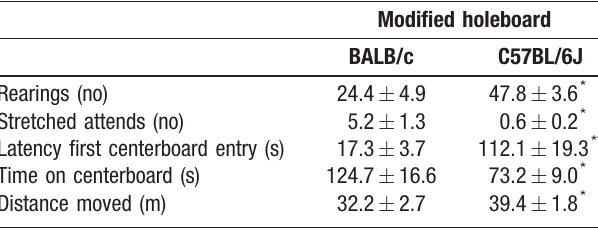
Table 3. Behavioral parameters of naı¨ve BALB/c and C57BL/6J mice in the modified holeboard.